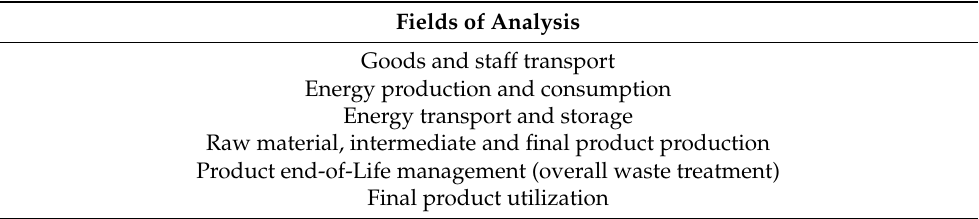
Table 3. LCI fields of